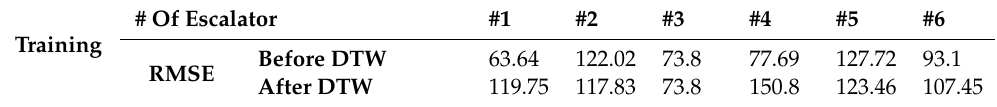
Table 3. Root-mean-square error (RMSE) in training